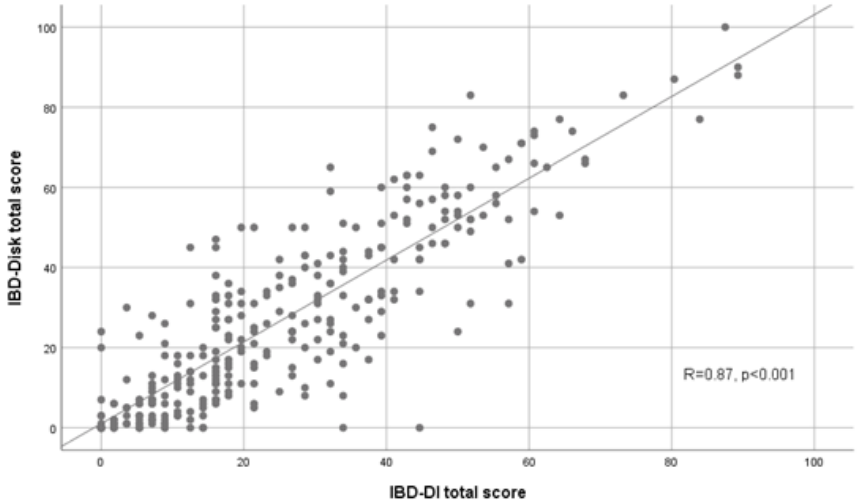
Figure 1. Correlation between the IBD-Disk total score and IBD-DI total score at baseline ( n = 300).